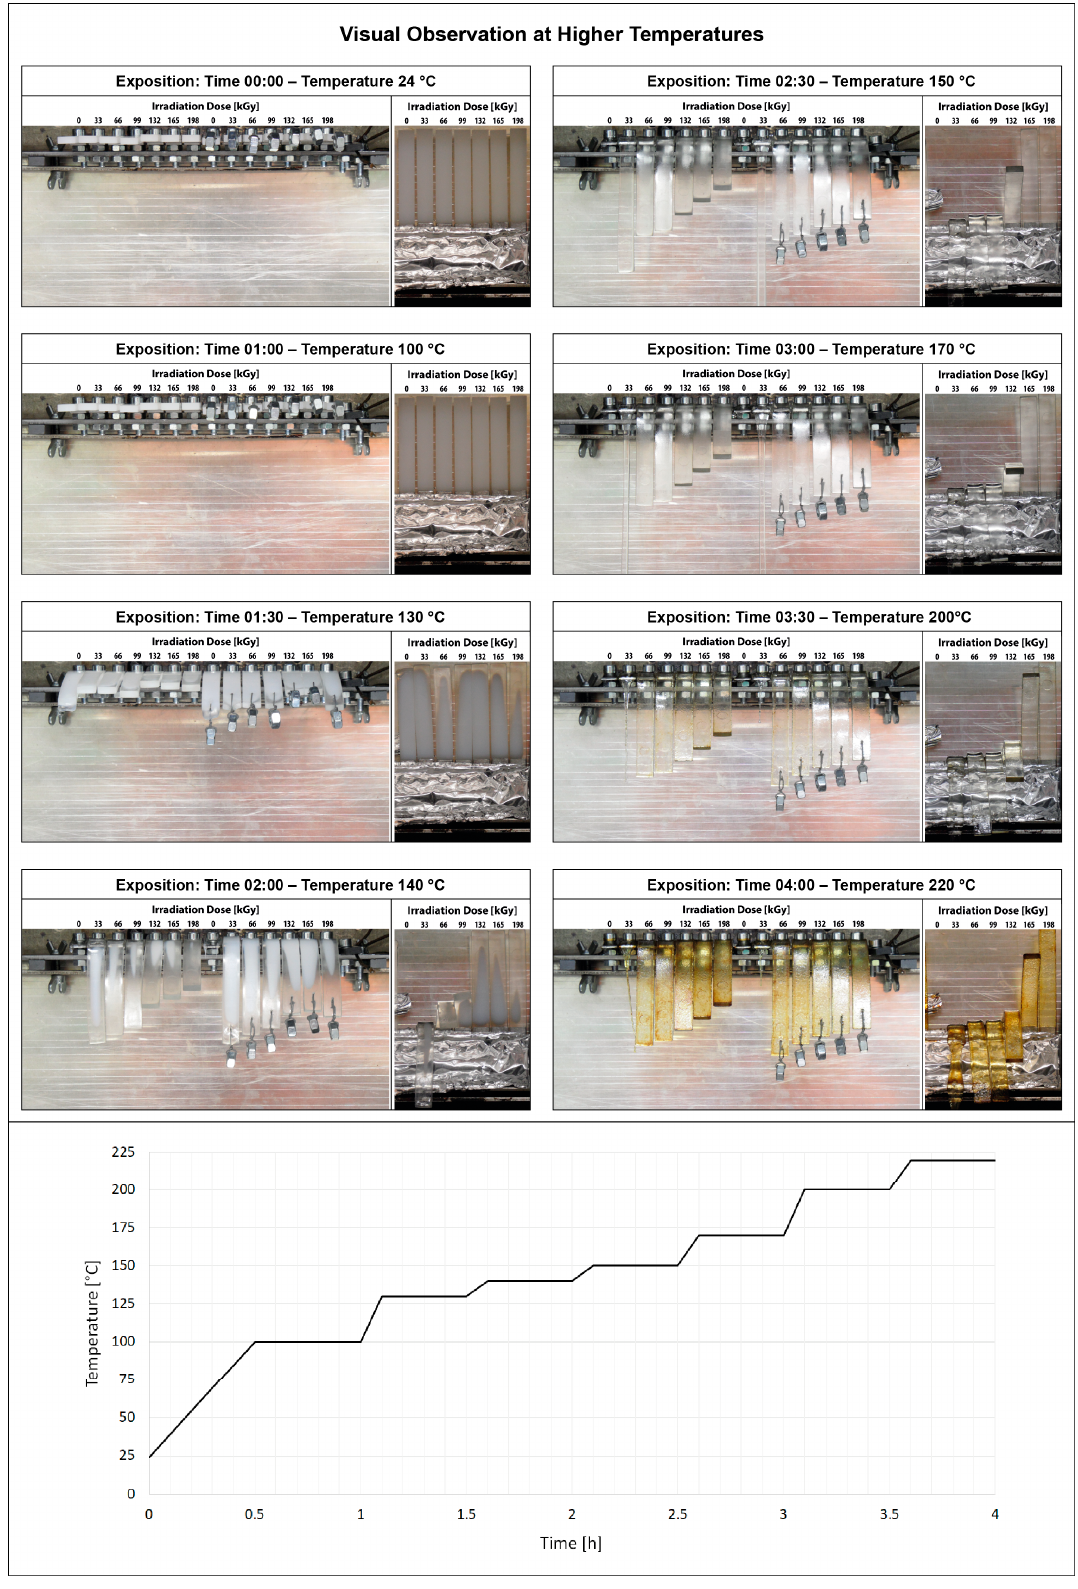
Figure 7. Visual observation of temperature stability in temperature chamber.